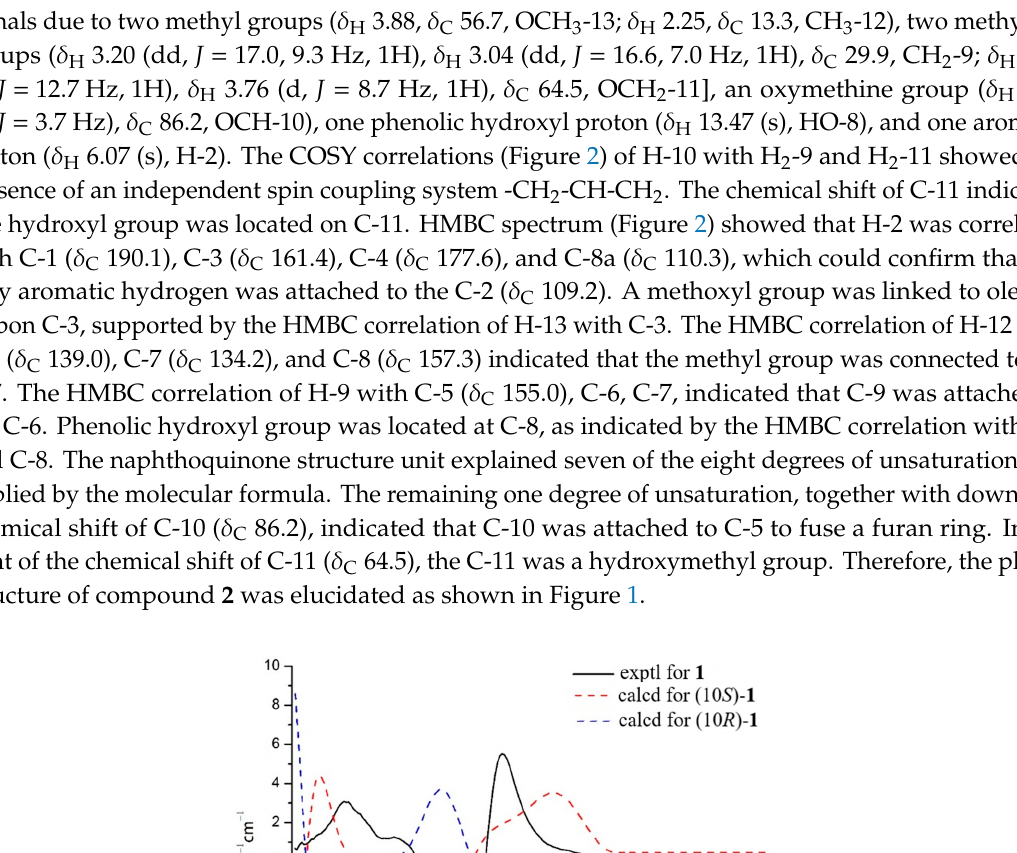
Figure 2. Key HMBC (red arrows) and COSY (blue bold lines) correlations of compounds 1 and 2.